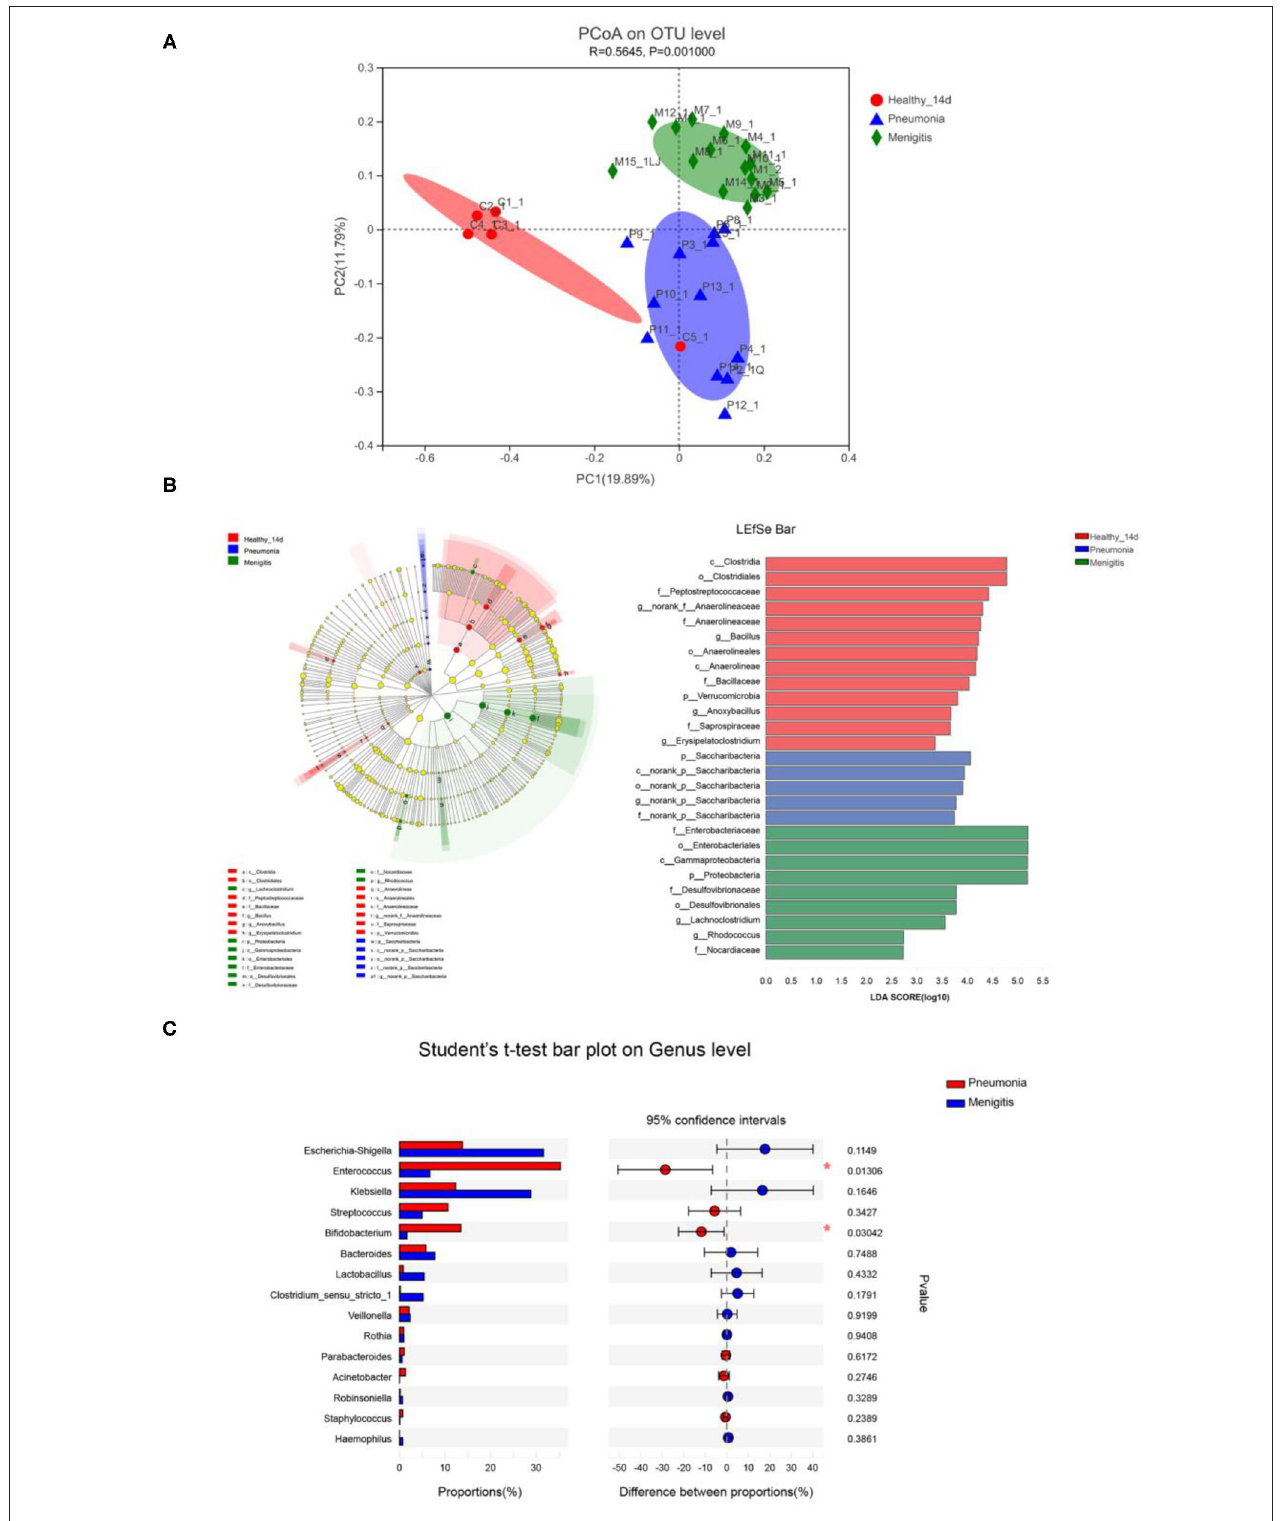
FIGURE 5 | Differences in gut microbiota between healthy newborns and patients before the use of antibiotics. (A) Principal coordinate analysis (PCoA) among healthy group and patient groups. (B) LEfSe analysis and LDA score among healthy group and patient group. (C) Relative abundance of significantly different genera between pneumonia group and meningitis group. * p <